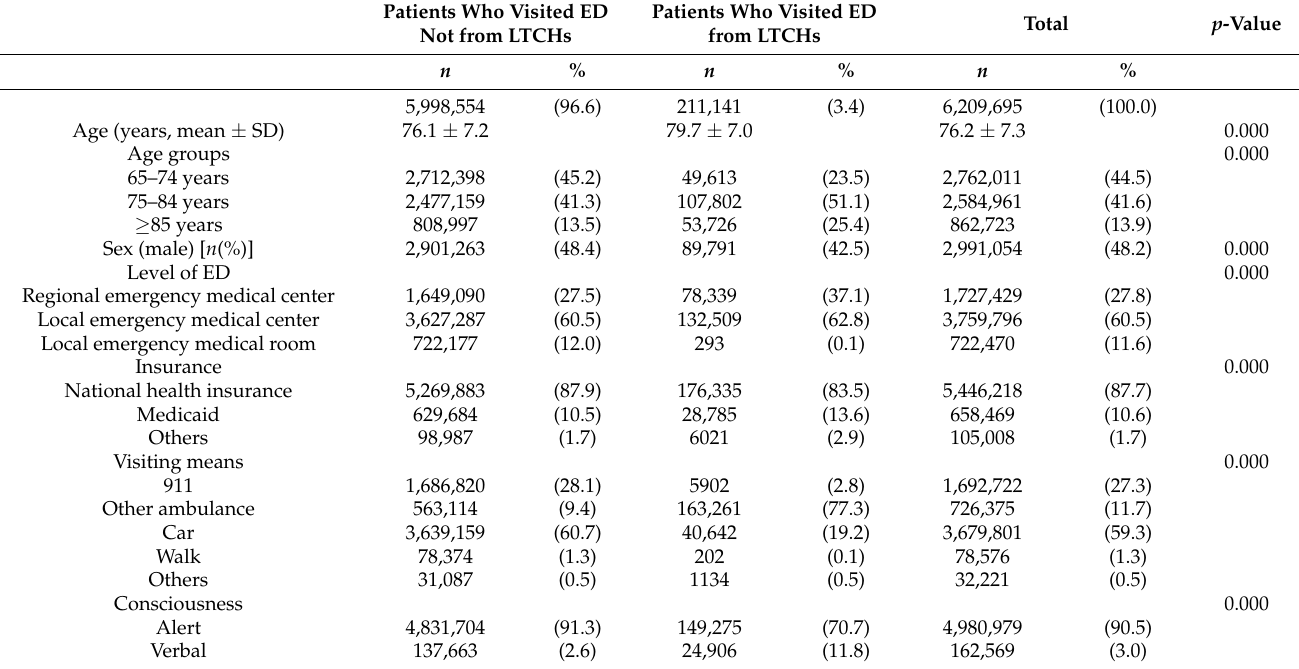
Table 1. Epidemiological and clinical characteristics of older patients who were admitted to EDs. Patients Who Visited ED Patients Who Visited ED Not from LTCHs from